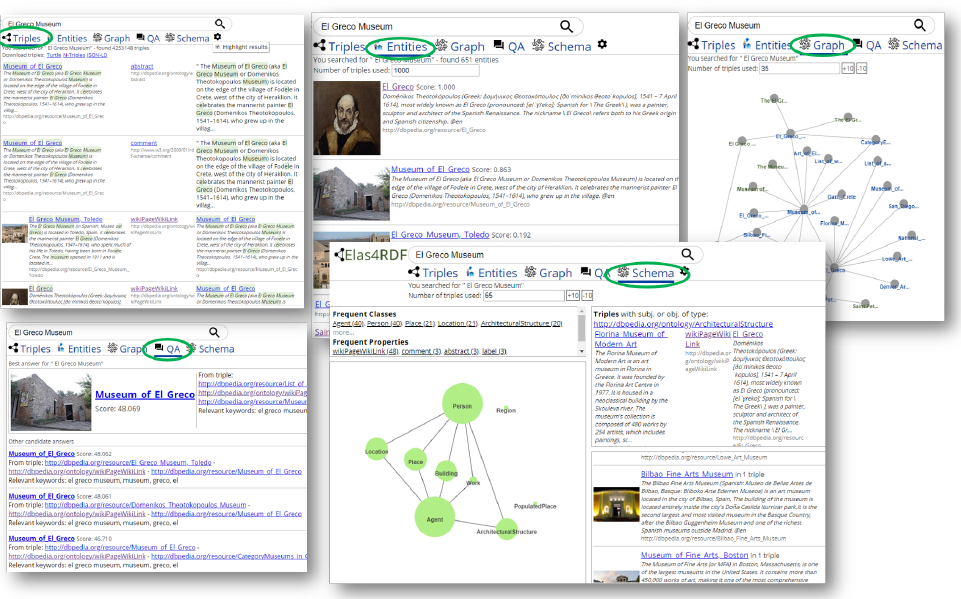
Figure 2. Search results for the query “El Greco